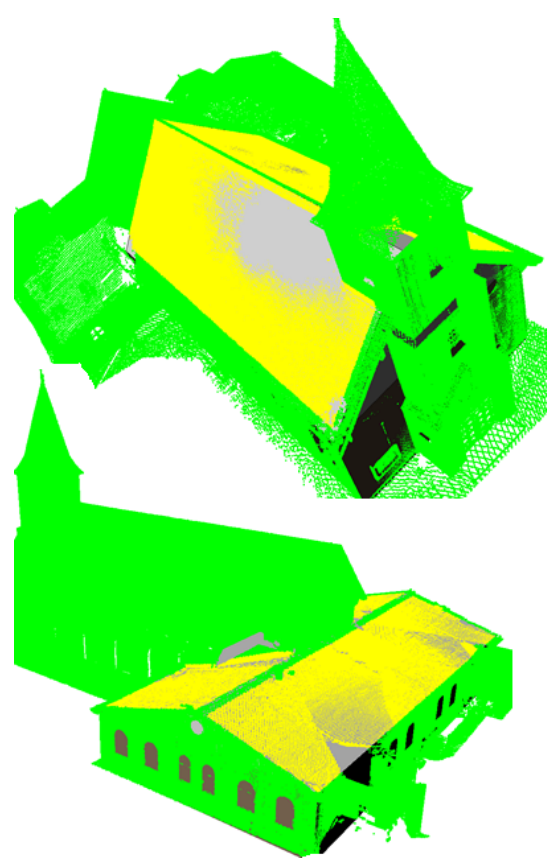
Figure 7: Data from LIDAR with a T-shaped building footprint decomposed into two separate non-overlapping